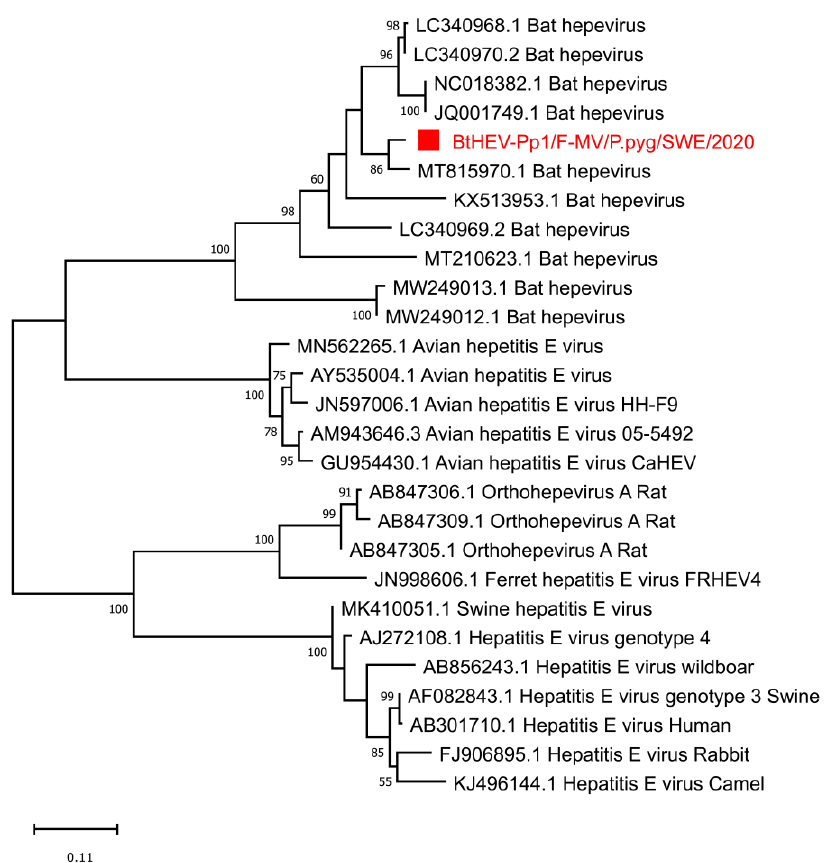
Figure 5. Phylogenetic analysis of bat hepevirus from Sweden based on predicted conserved RdRp protein. The sequence reported in this study, BtHEV-Pp1/F-MV/P.Pyg/SWE/2020 (ON513427) (indicated by red square boxes and red text), and the closest sequence matches from Genbank and ICTV reference sequences from within the Hepeviridae family are included in the analysis. The tree was generated using MEGAx and a maximum likelihood model with 500 bootstrap iterations on ClustalW aligned amino acid sequences, with a total length of 351 amino acids. Only bootstrap values above 50 are displayed on the nodes.